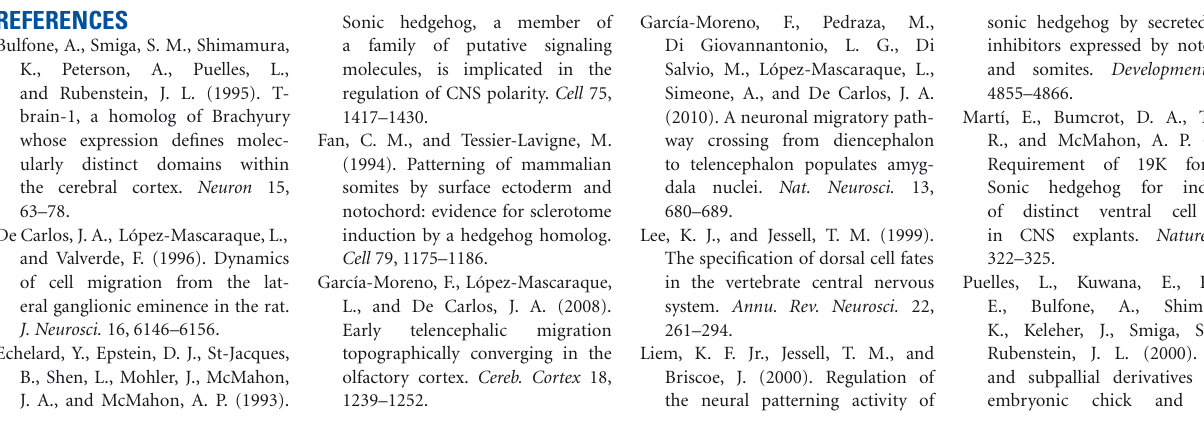
express CR (red). (D–F) Many of the GFP-cells that originate in the ventricular zone of the subpallium (green) co-express Tbr1 (red; D,E ). (F) Subpallial-derived cells do not express CR (red). Coronal sections; midline is to the right and dorsal is up. Scale bars: A,D , 200 µ m ; B,C,E,F , 100 µ